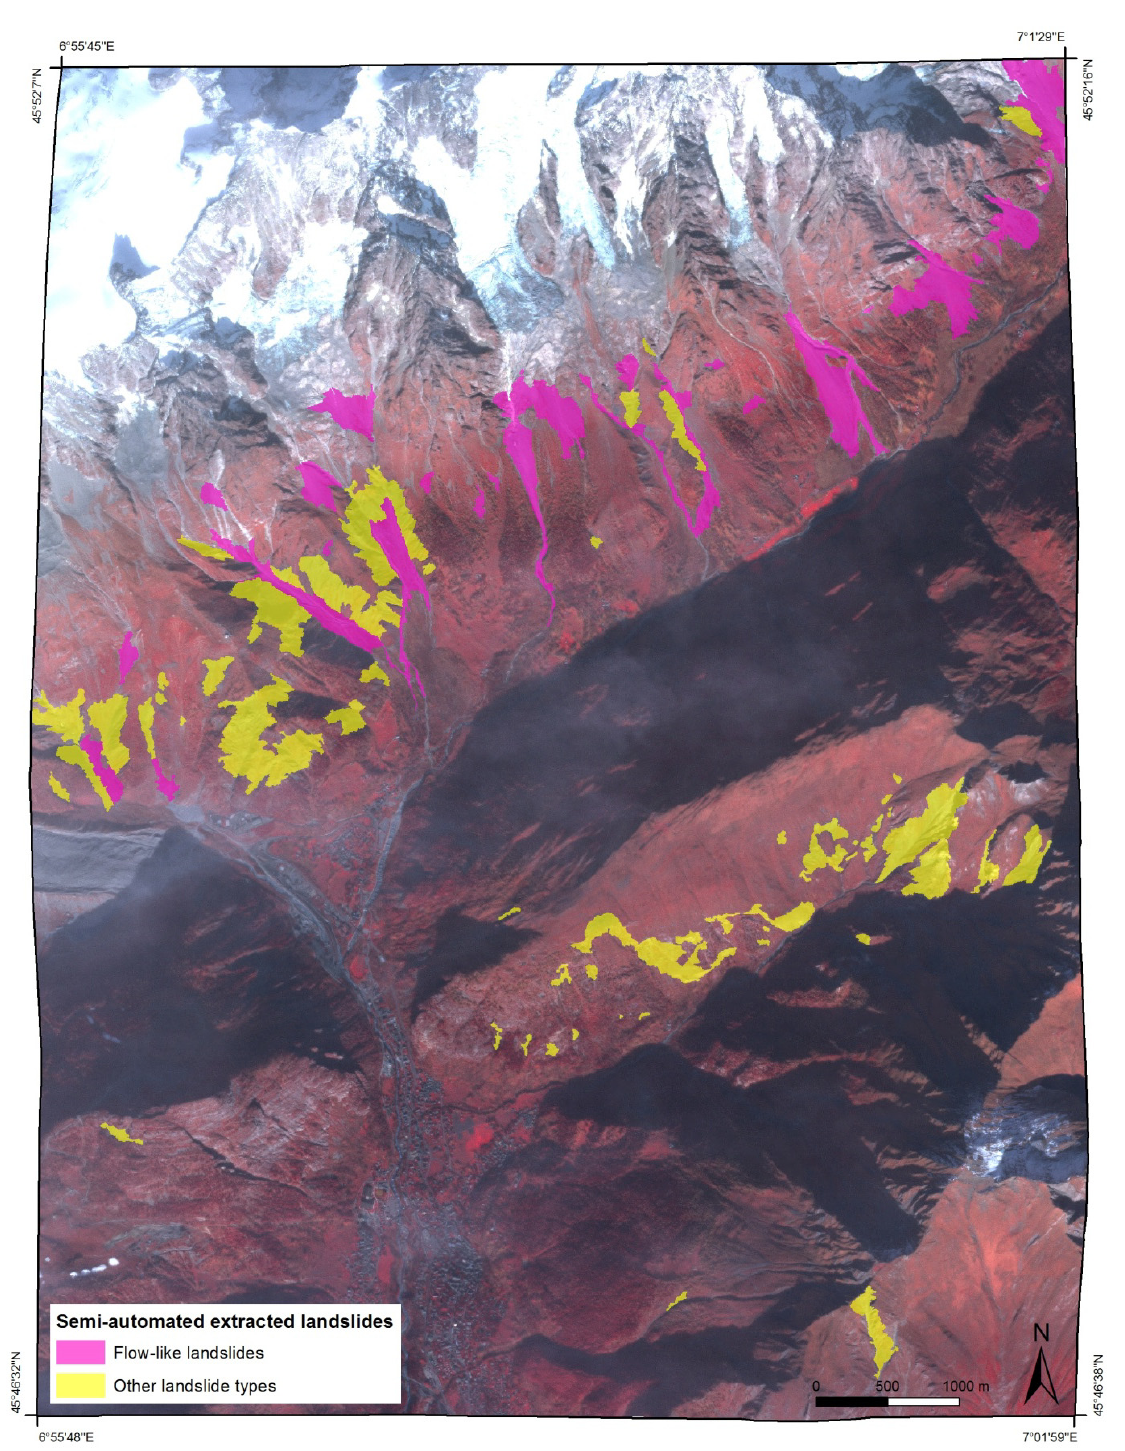
Figure 7. Result of the object-based landslide detection based on the SPOT-5 imagery (acquisition date: 5 May 2005, false color composite). Pink areas represent flow-like landslides and yellow areas indicate other landslide types